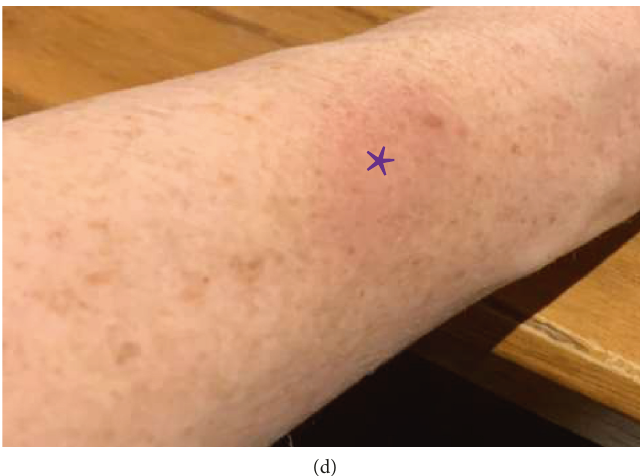
Figure 11: (a–c) Postcontrast sequence shows capsular contracture and focal thickness of the fibrous capsule (a). Silicone sensitive sequence (b) shows the granuloma and extracapsular silicone material in the pericapsular space. Microscopy of the implant (c) shows surface degradation in a smooth surface implant (yellow asterisk). There is also fat inside the implant. The patient also shows eczemas in the body, exemplifying the eczema in the right arm with the purple asterisk (d).